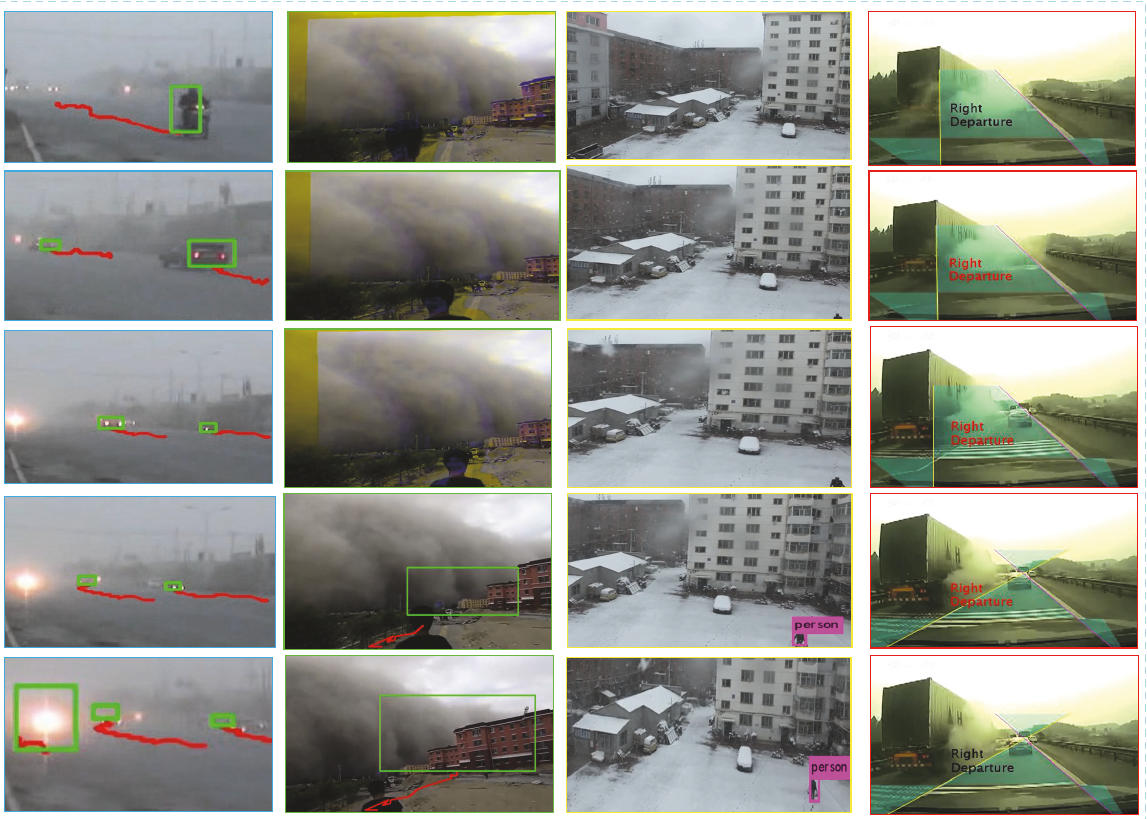
Figure 5: Examples of learning periods for video recognition in different surveillance scenarios for detailed analysis on the time complexity, under implications of smog (in the blue-rectangles, captured by an android camera), sandstorm (in the green rectangles, captured by a webcam on mobile), blizzard (in those yellow rectangles with videos collected from a drone), and truck exhaust (in the red rectangles with videos collected by a driving